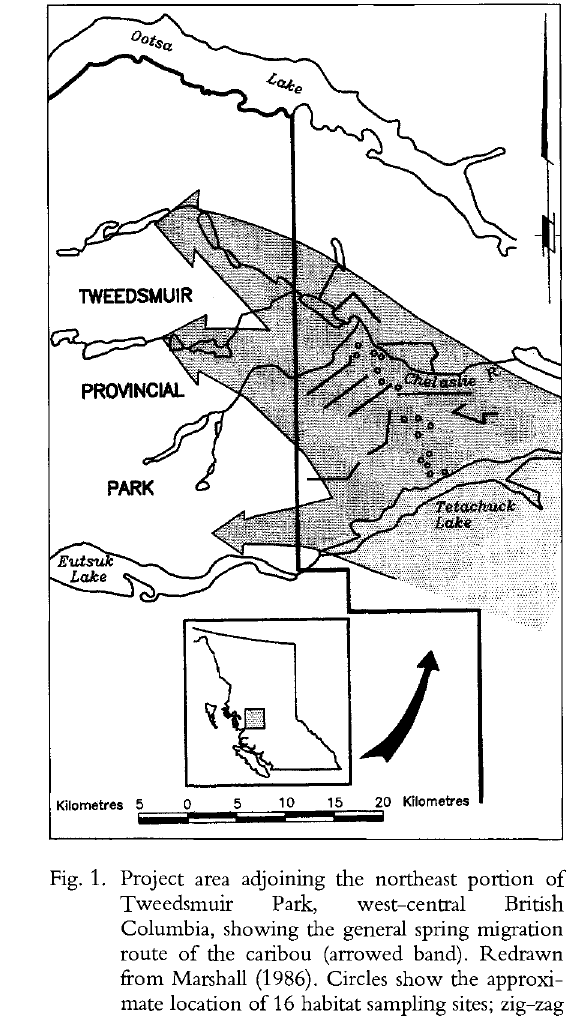
Fig. 1. Project area adjoining the northeast portion of Tweedsmuir Park, west-central British Columbia, showing the general spring migration route of the caribou (arrowed band). Redrawn from Marshall (1986). Circles show the approxi mate location of 16 habitat sampling sites; zig-zag lines represent 10 habitat survey transects.